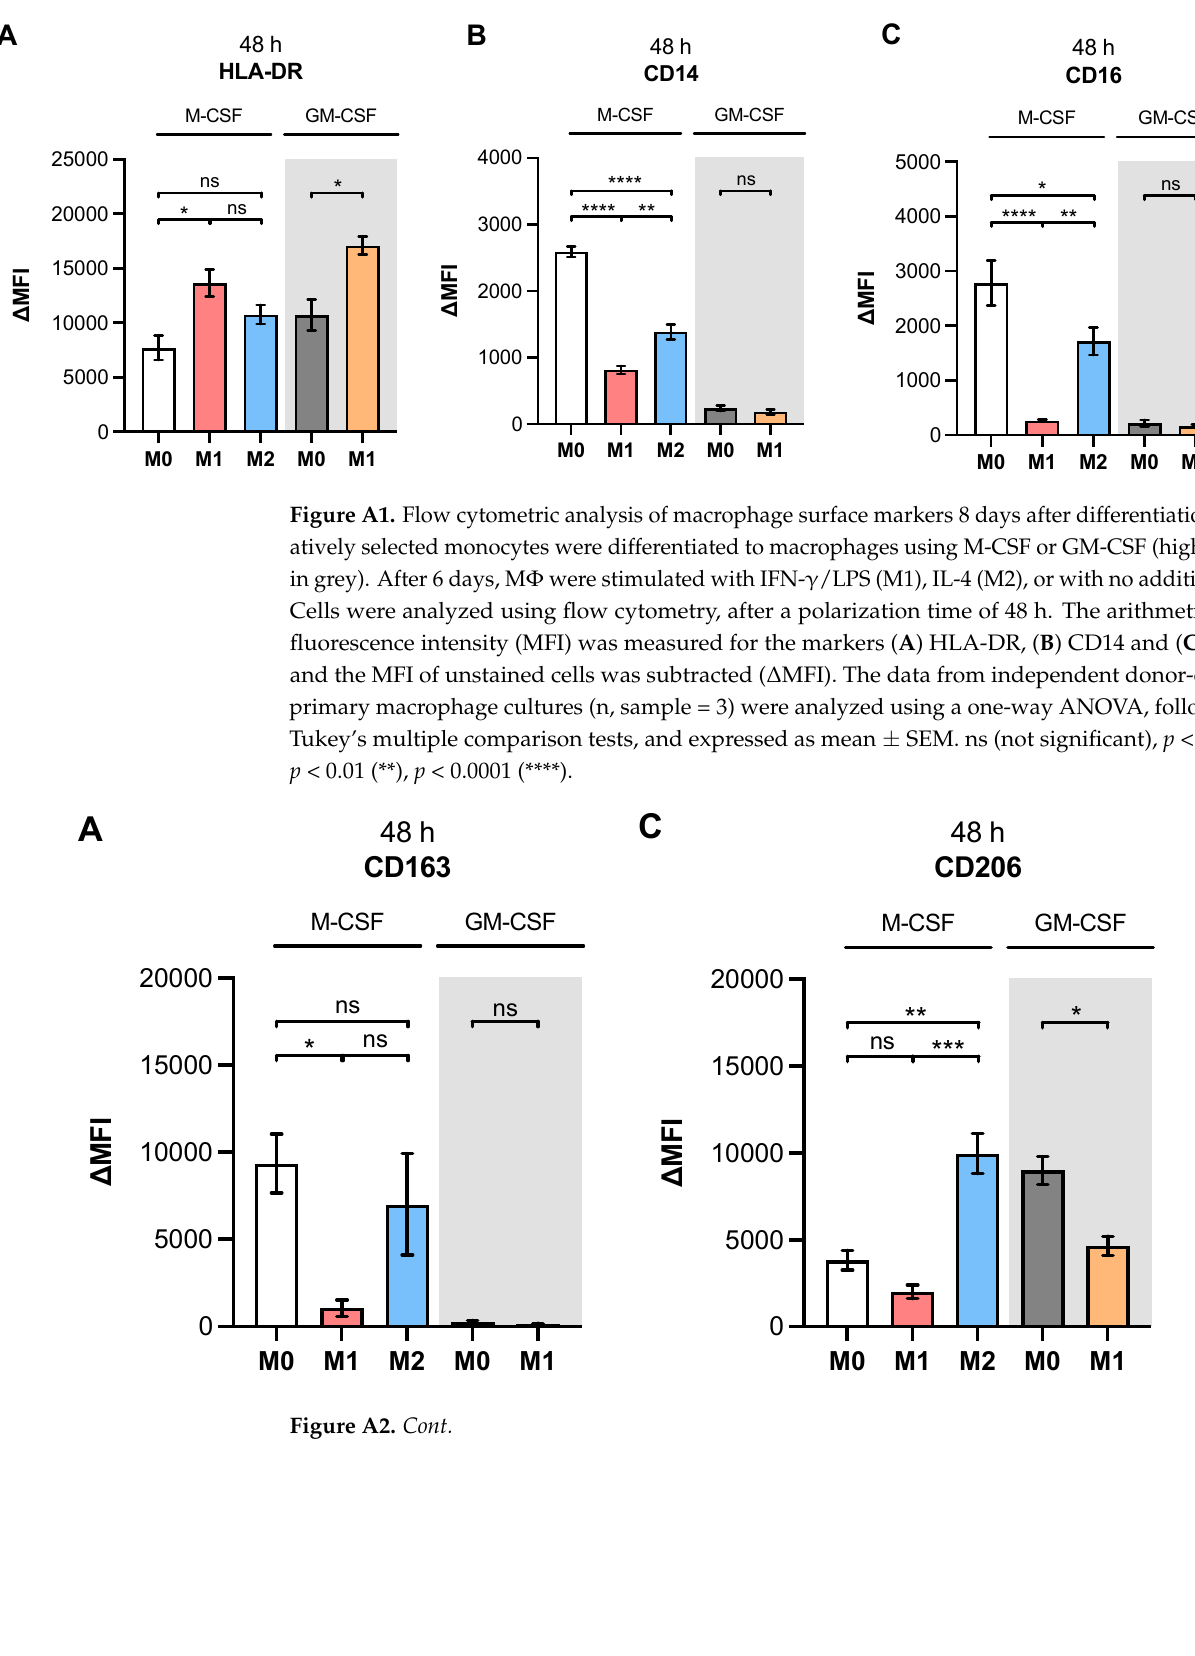
23 of 28 Table A1. Literature-based analysis of the protein markers used for the phenotypic characterization of the M Φ subtypes generated in this study. All of the studies cited were derived from human M Φ polarized toward an M1- or M2-like phenotype using different stimuli. The column “phenotype” describes the marker expression in the M1- or M2-like M Φ subtype, compared to each other. The column “regulation” gives the marker expression changes with respect to the M Φ phenotype indicated. Expression increases were indicated by the symbol “ ▲ ,” decreases by the symbol “ ▼ ,” and no significant changes with “ ↔. ” Marker